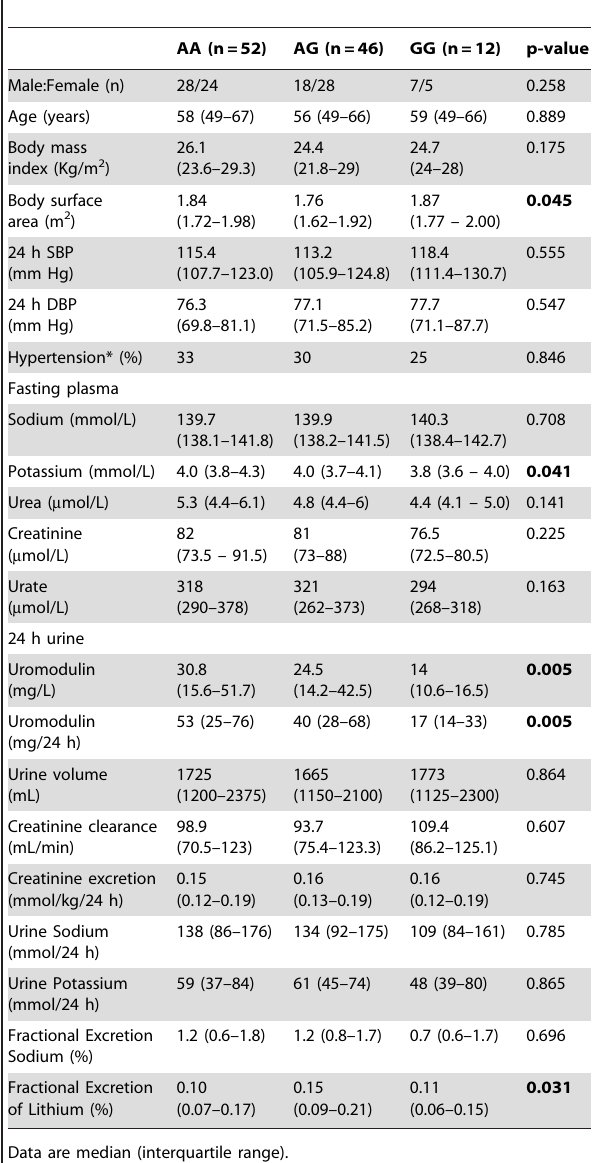
Table 4. Univariate association analysis of rs13333226 in 256 hypertensive patients from the BRIGHT